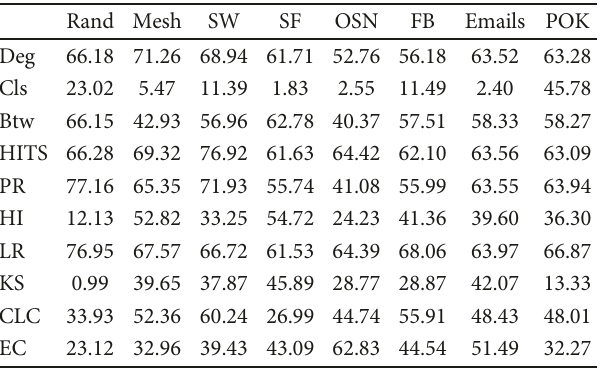
Table 3: Average performance of the 10 ranking methods on the 8 datasets. Performance is expressed as opinion coverage (%) obtained in the one-to-one opinion di ff usion competitions with every other ranking